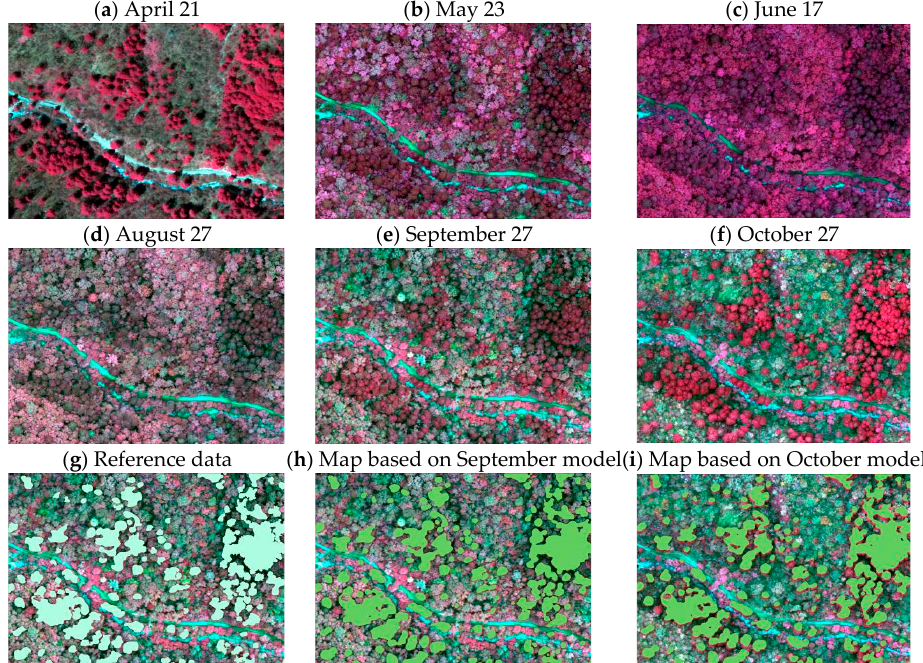
Figure 5. UAV-based multispectral orthomosaics in different months and the associated Faxon fir identification map: ( a ) April 21, ( b ) May 23, ( c ) June 17, ( d ) August 27, ( e ) September 27, ( f ) October 27, ( g ) manually labeled reference data in September; ( h ) identi fi cation map of MS imagery on Sep- tember model (highest accuracy), and ( i ) identi fi cation map of MS imagery on October model (lo w- est accuracy).